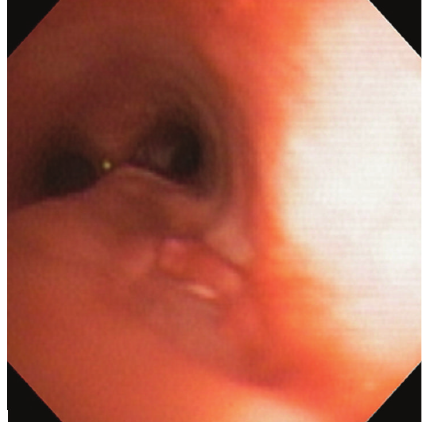
Figure 4: Postrepair bronchoscopic view of the tracheal